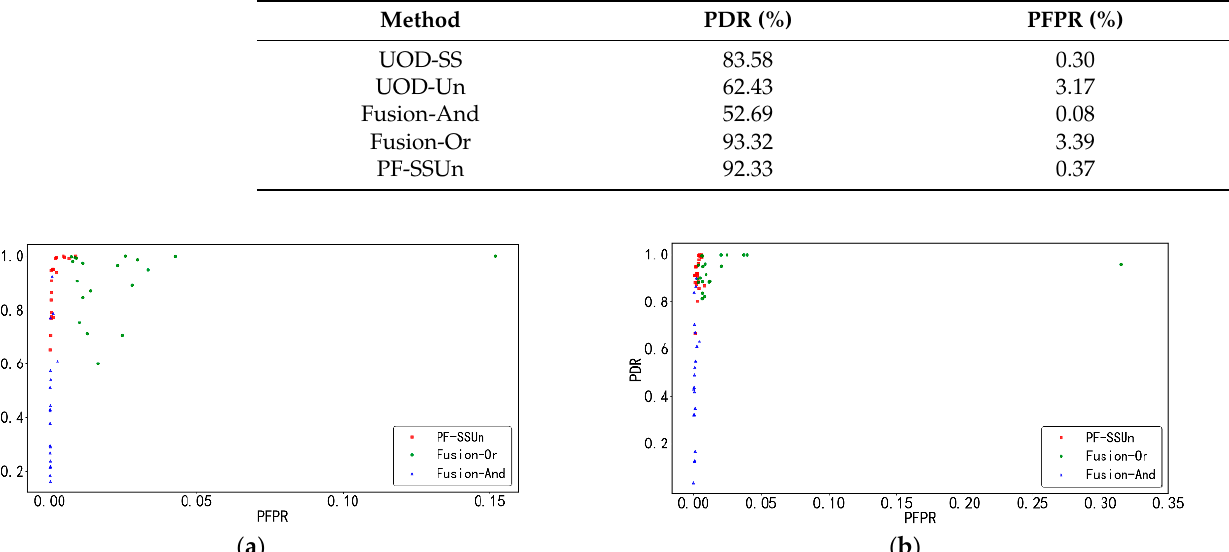
Figure 10. PDR over PFPR scatter plot of the three fusion strategies: ( a ) Scene 1; ( b ) Scene 2. Table 2. Comparison of performance indicators between independent method before fusion and different fusion